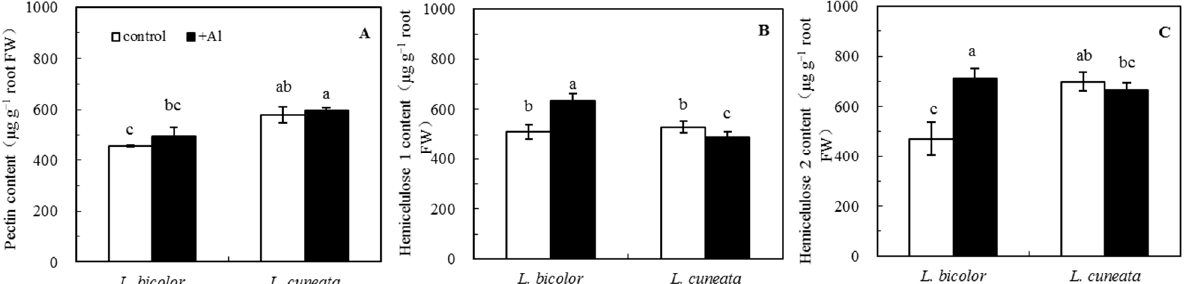
Figure 5. Effect of Al treatments on the contents of polysaccharides in root tips of two Lespedeza species. ( A ) pectin, ( B ) HC1, and ( C ) HC2. Lespedeza seedlings were exposed to 0.5 mM CaCl 2 solutions (pH 4.5) with or without 50 µ M Al for 24 h. Root apices (0–1 cm) were cut and cell wall polysaccharides were fractionated into pectin, HC1, and HC2 for glucose-content measurement. Significant differences between mean values are indicated by different letters at the p < 0.05 level (Tukey test). Error bars represent ±SD ( n = 3).